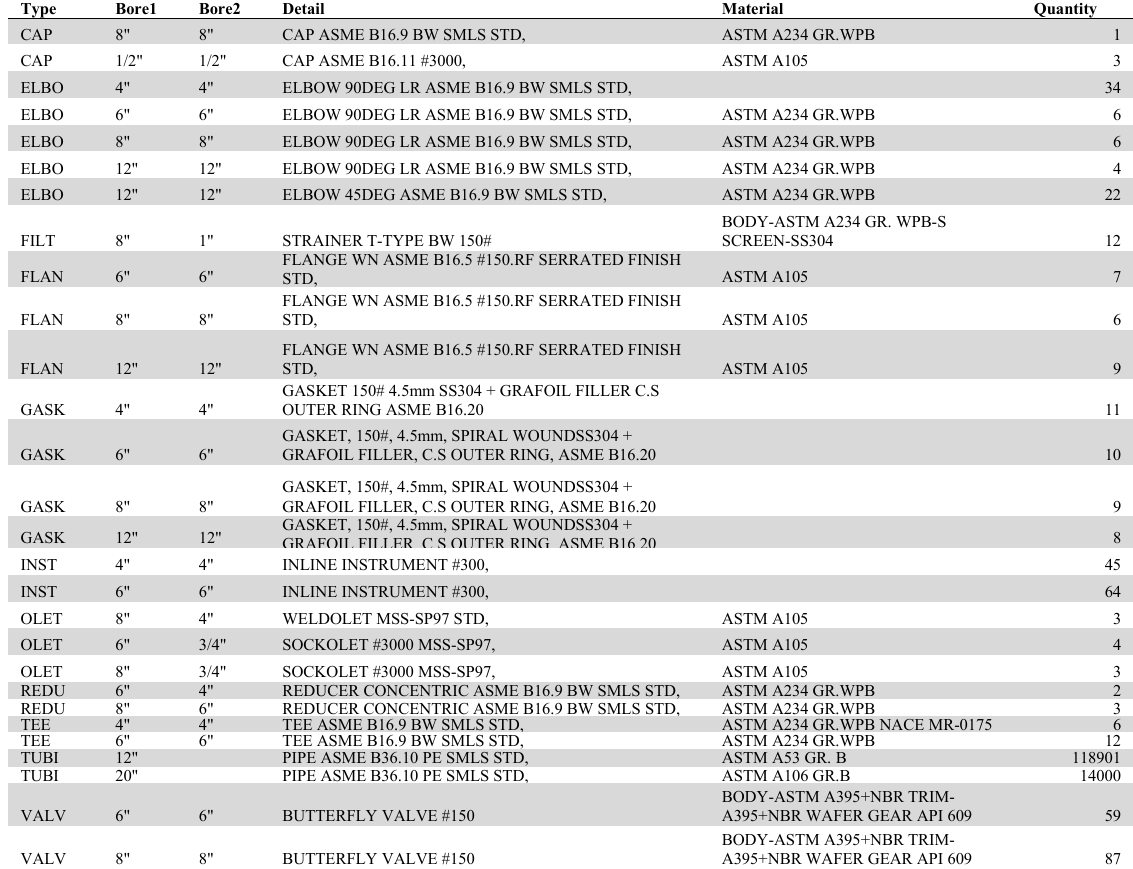
Fig. 10. Sample Bill of Quantity